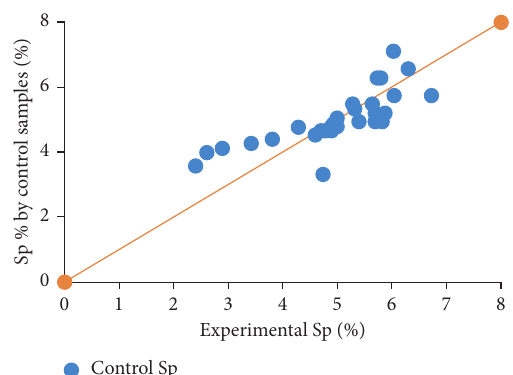
Figure 4: Relationships between experimental and controls Sp.